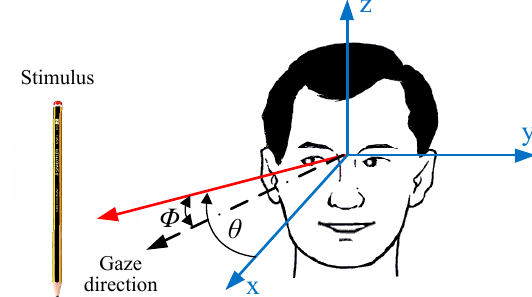
Figure 1. Spatial representation of eye movements to a stimulus.